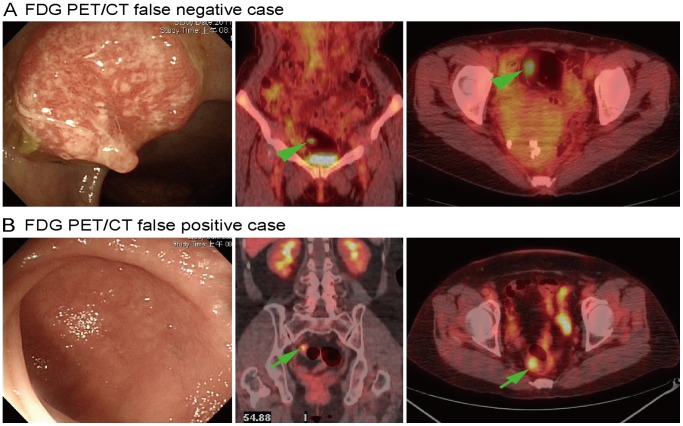
Representative cases of false-negative (panel A) and false-positive (panel B) FDG PET/CT findings.(A) One polypoid cancer (1.5 cm in size) was identified by colonoscopy in the sigmoid colon. FDG PET/CT scans revealed an increased FDG uptake in the luminal air (arrowhead). This result was erroneously interpreted as a negative finding because of misregistration. (B) Colonoscopy revealed a normal mucosa. However, FDG PET/CT showed an increased FDG uptake in the sigmoid colon (arrow), which was erroneously interpreted as a positive result.